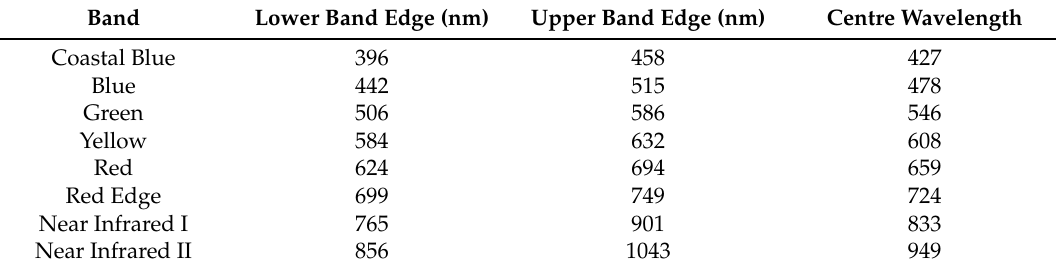
Table 1. Worldview-2 bands and their